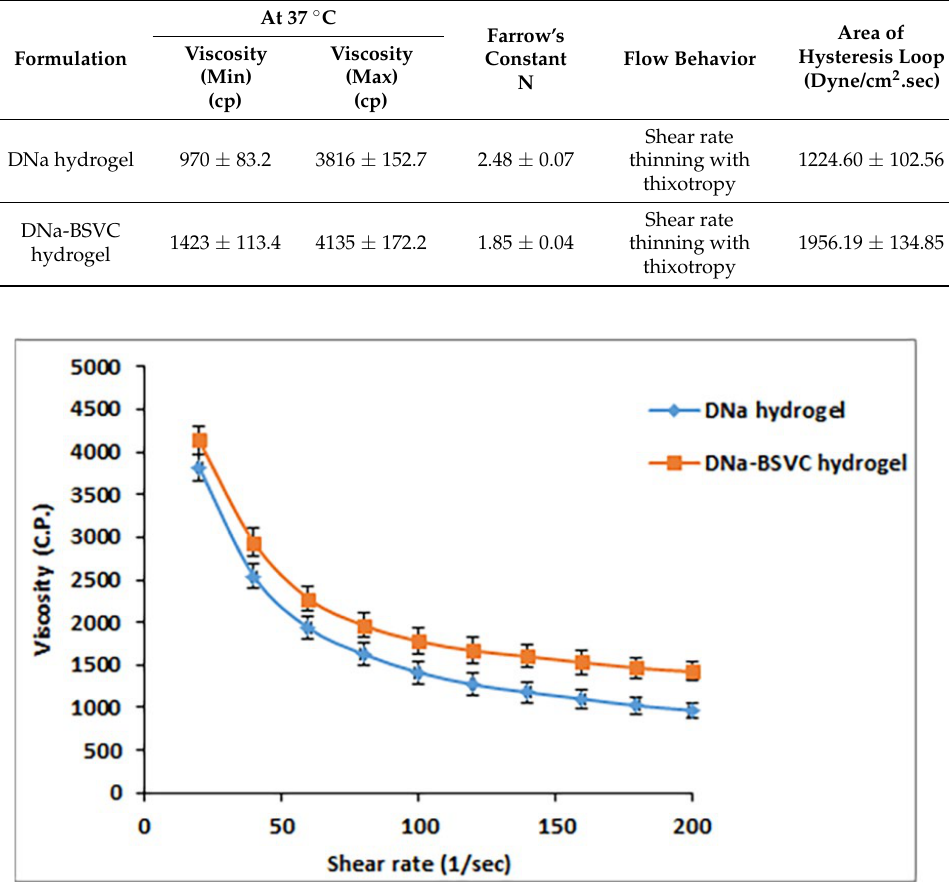
Figure 7. Rheology of DNa hydrogel and DNa-BSVC hydrogel formulations at 25 ± 1 °C ( n = 3 ± SD). Thixotropy means that the viscosity of the fluid reduces with the rise of shear stress. Table 5. Rheological parameters of the prepared DNa hydrogel and DNa-BSVC hydrogel. After the shear stress is withdrawn, the viscosity returns gradually to the former state under isothermal conditions. The characteristic thixotropy flow curve descends moving toward the left compared with the ascending curve. Needless to say, thixotropy is a desirable character in pharmaceutical gels. The degree of thixotropy was calculated